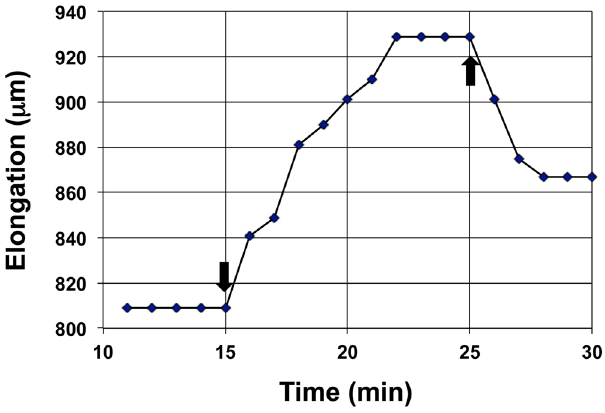
Figure 4. The results of a modified constant-tension extension experiment is presented. At ten minutes a weight (1.24 g) was used to apply constant tension to a five millimeter long section of a frozen-thawed wall that includes the growth zone 30 , and an initial extension of approximately 810 µ m is observed (see Calculations, Estimates, and Methods – ‘Constant-tension extension experiment’ for more details). At 15 min (marked by the downward pointing arrow), 50 mM potassium-acetate buffer, pH = 4.5, replaces the bathing water (pH = 7.0) in the test apparatus 30 . Immediately, creep extension is observed until 22 min on the time scale. At 25 min (marked by the upward pointing arrow) the tension is released and the extension decreases (recovered elastic extension) until 28 min on the time